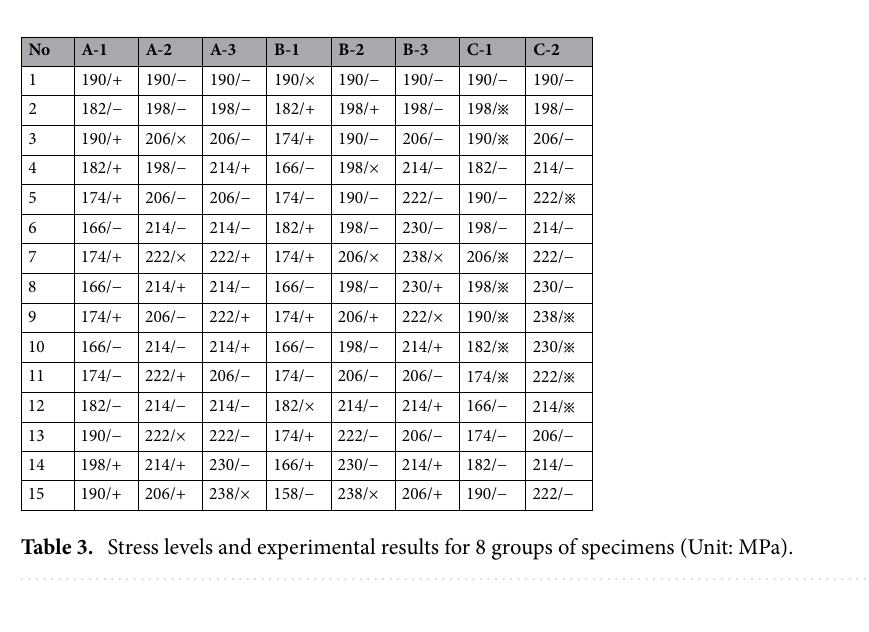
Figure 2. Fracture morphology comparison of different fracture modes.